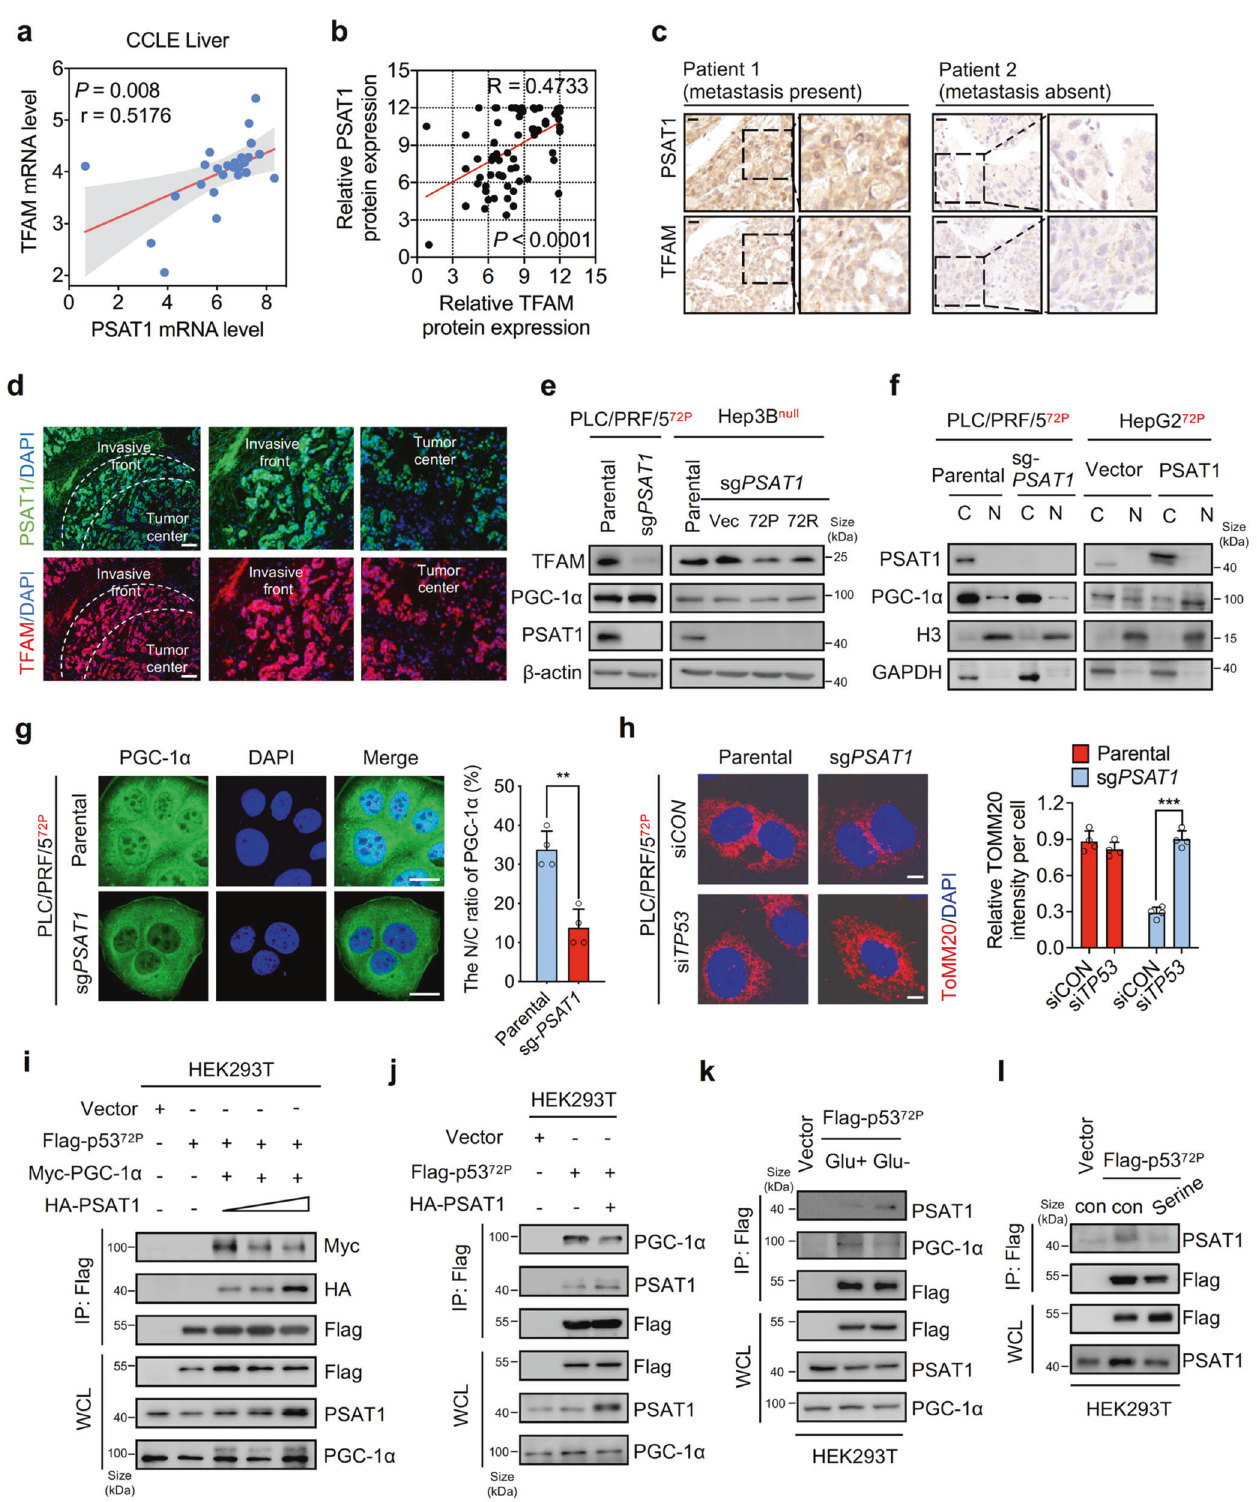
complete dietary inhibition of serine seems dif fi cult and the effect of serine on tumor metastasis remains largely unclear. PSAT1 is the second rate-limiting enzyme during serine biosynthesis, which catalyzes the conversion of 3-phosphohydroxypyruvate (PHP) and glutamate to 3-phosphoserine (PS) and α -KG. 38 The aberrant expression of PSAT1 has been observed in several cancer